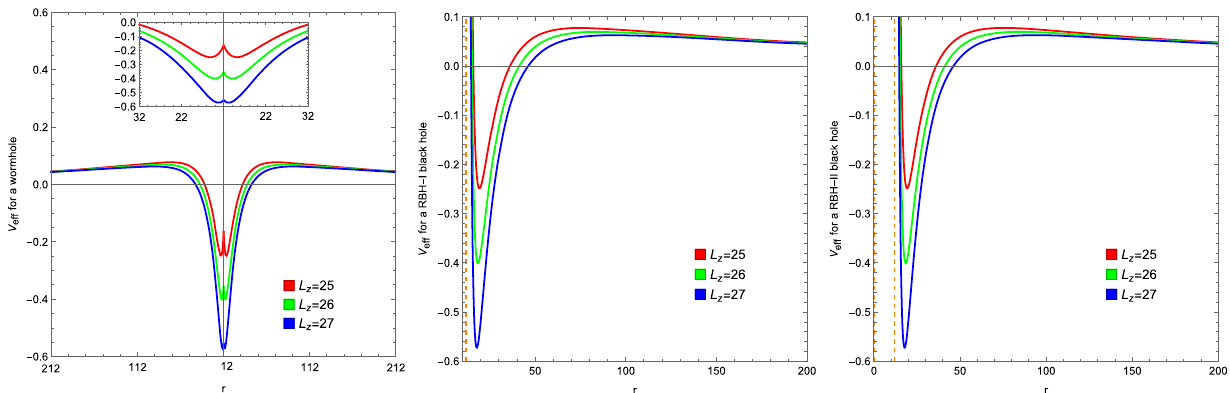
Fig. 1 Plots of the effective potential V eff of a massive particle travel- ling on the equatorial plane with θ = π/ 2 as a function of radius r in a traversable wormhole with (cid:5) = 12 (left panel), a RBH-I black hole with (cid:5) = 1 (middle panel) and a RBH-II black hole with (cid:5) = 0 . 08 (right panel) for L z = 25 (red lines), L z = 26 (green lines) and L z = 27 (blue lines). We have M = 6, a = 1 and E = 1. The horizons of the RBH-I and RBH-II black holes are represented by orange dashed lines.